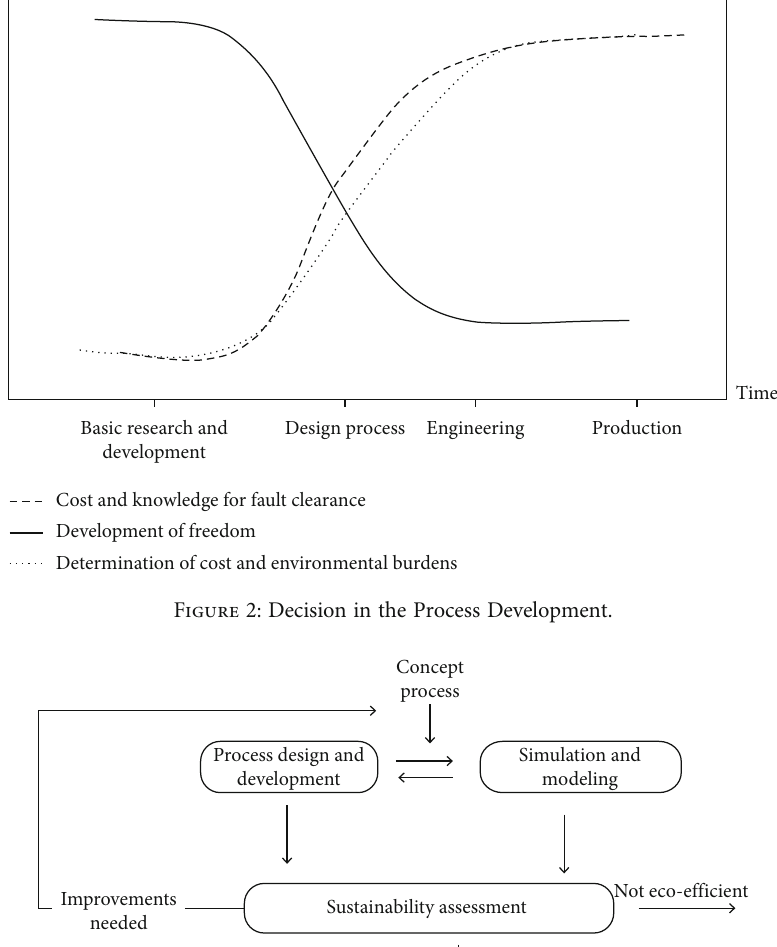
Figure 3: Process development of